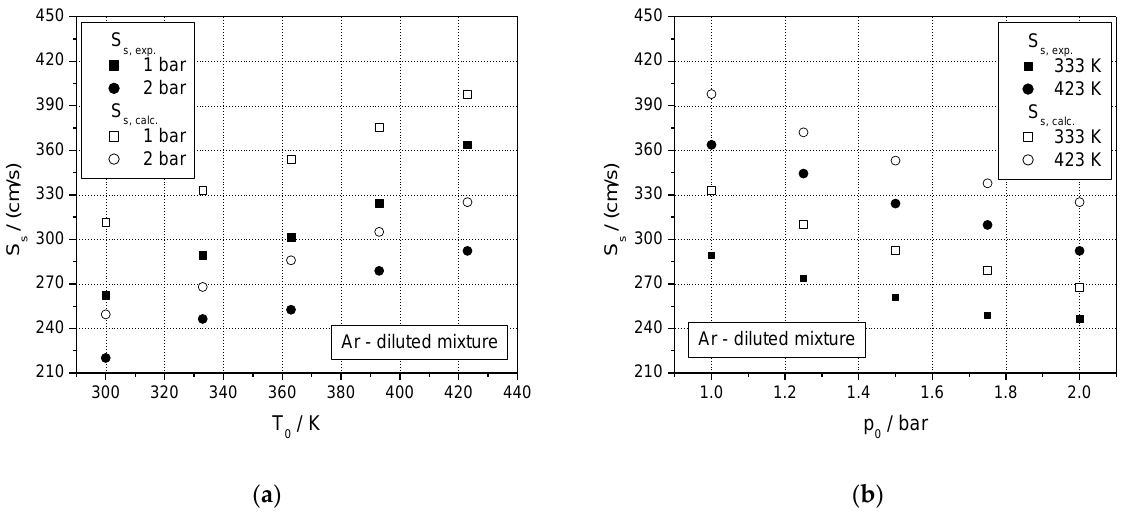
Figure 5. Comparison of experimental and calculated PVs of stoichiometric C 3 H 8 -air diluted with 10% Ar at: ( a ) various initial temperatures; ( b ) various initial pressures.